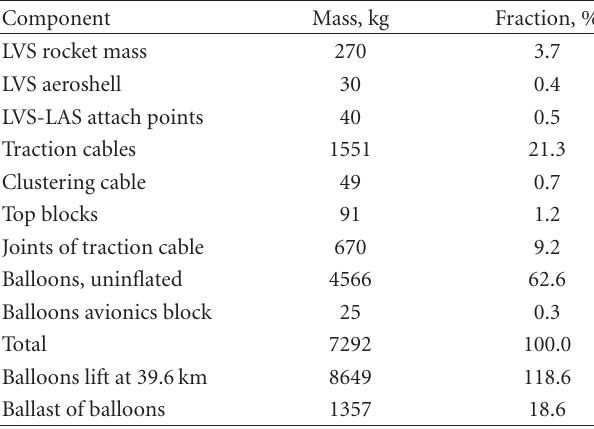
Table 3: Mass budget of the proposed LAS.